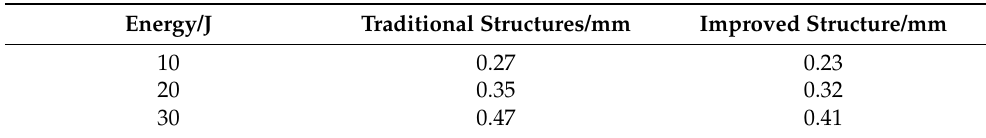
Table 5. Comparison of face sheet deformation depth of two structures under different impact